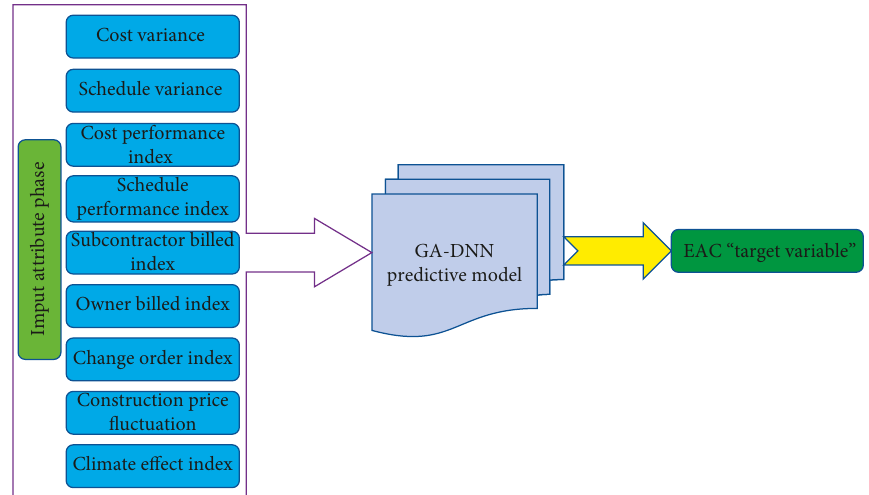
Figure 4: Input-output variables system structure using the hybrid intelligent GA-DNN predictive